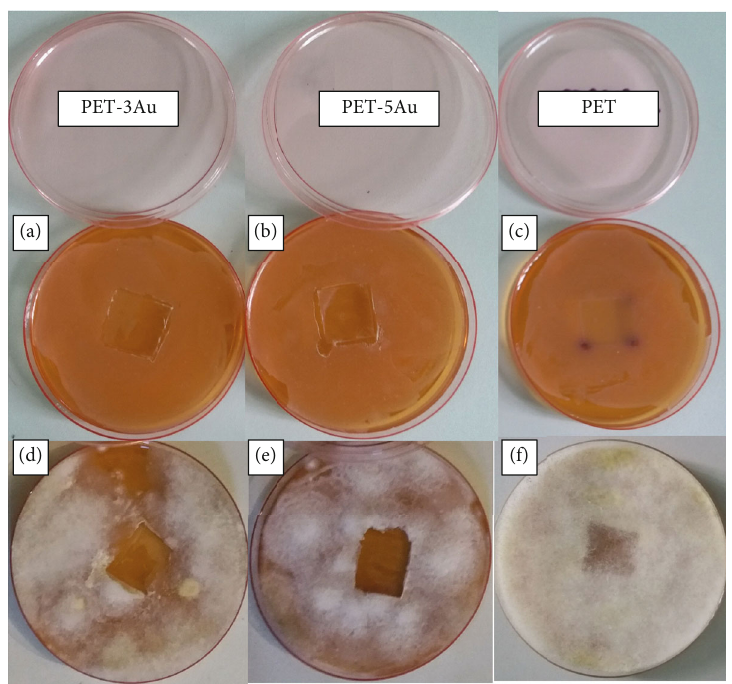
Figure 8: Antimicrobial activity of AuNPs for 1 day (a, b, c) and 7 days (d, e,